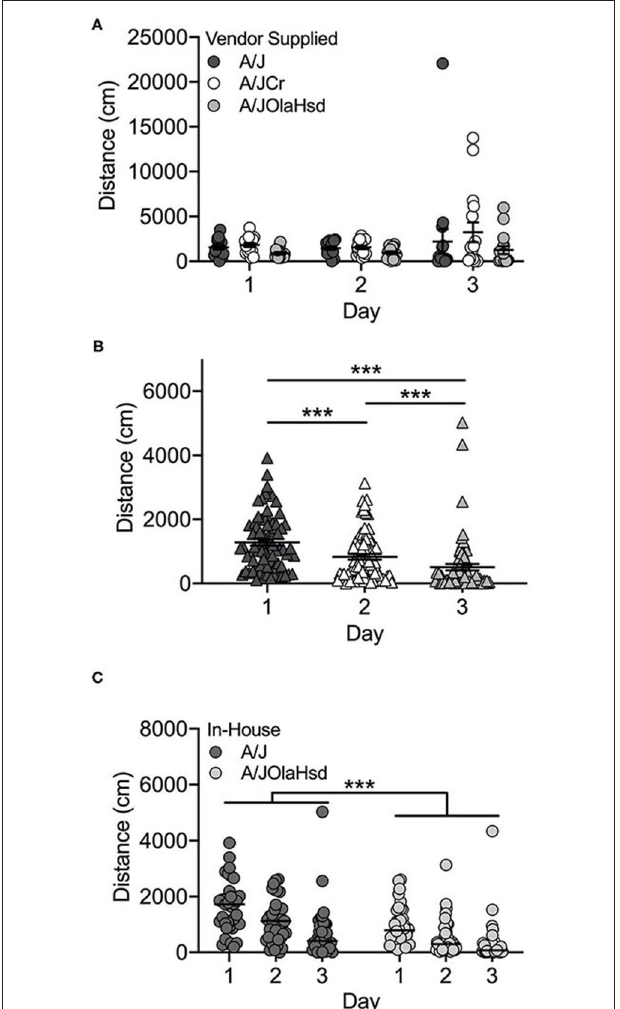
FIGURE 1 | A/J substrains are not activated in response to cocaine. (A) Vendor-supplied A/J substrains do not exhibit increased activity in response to cocaine on Day 3; (B) locomotor activity decreases across all three days of testing in A/J and A/JOlaHsd substrains bred in-house and (C) A/J mice are significantly more active than A/JOlaHsd mice regardless of day. Each data point represents an individual mouse, error bars are SEM. *** p < 0.001.